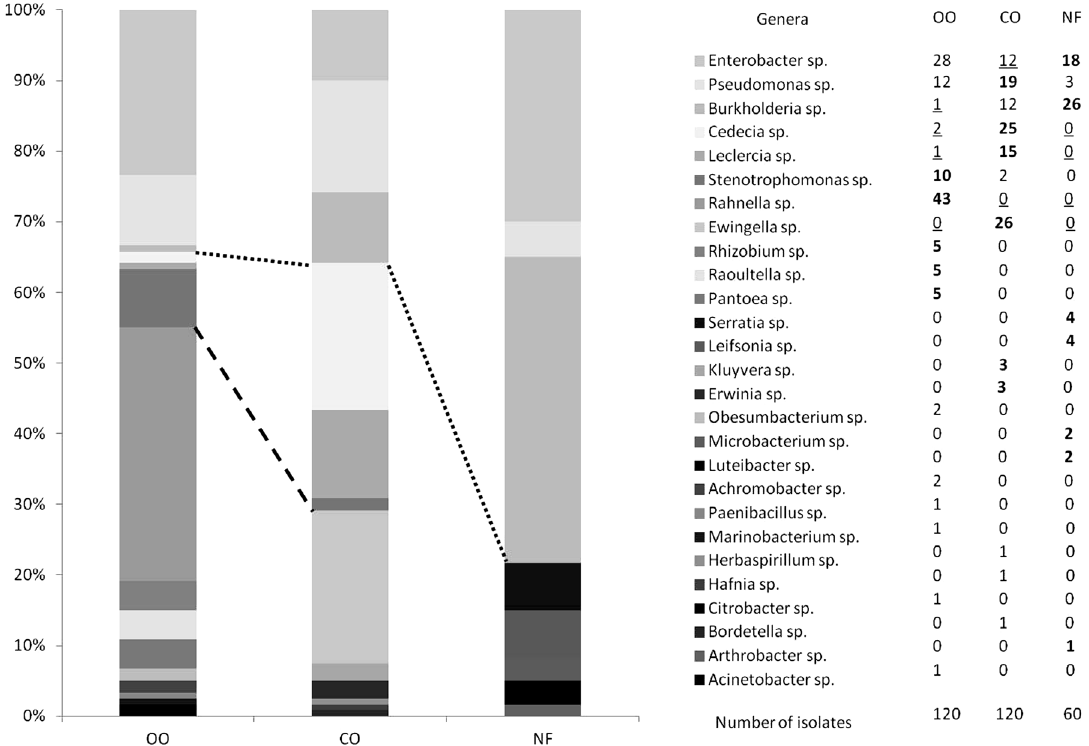
Figure 1 - Bacterial community composition from soil under different management conditions. Different gray shades represent the dominance of each genusineachsoilcondition(representedbybars).Generaabovethedottedlinewereubiquitous,andgenerabetweenthedottedanddashedlinesoccurred under both orchards. Bold = excessive number of bacteria occurring in that condition; Underline = less bacteria than expected occurring in that condition. NF = Native field, CO = Conventional Orchard, OO = Organic Orchard.